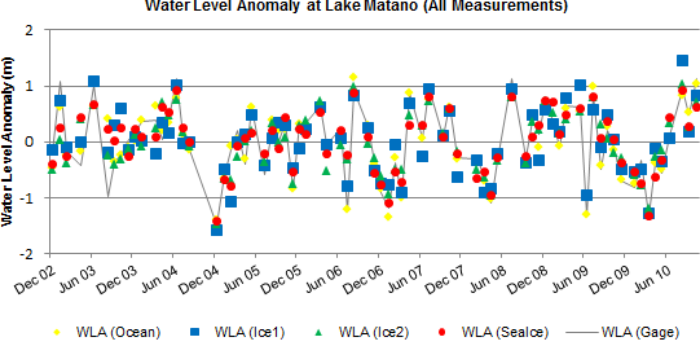
Figure 13. Water level anomaly at Lake Matano as measured by Envisat RA-2 and processed by all retrackers, compared with in situ measurement.